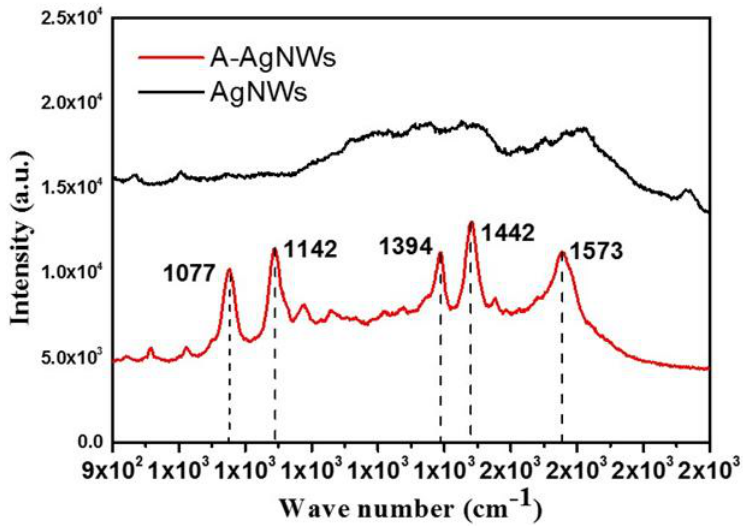
Figure 2. Raman spectra of AgNWs and A-AgNWs.